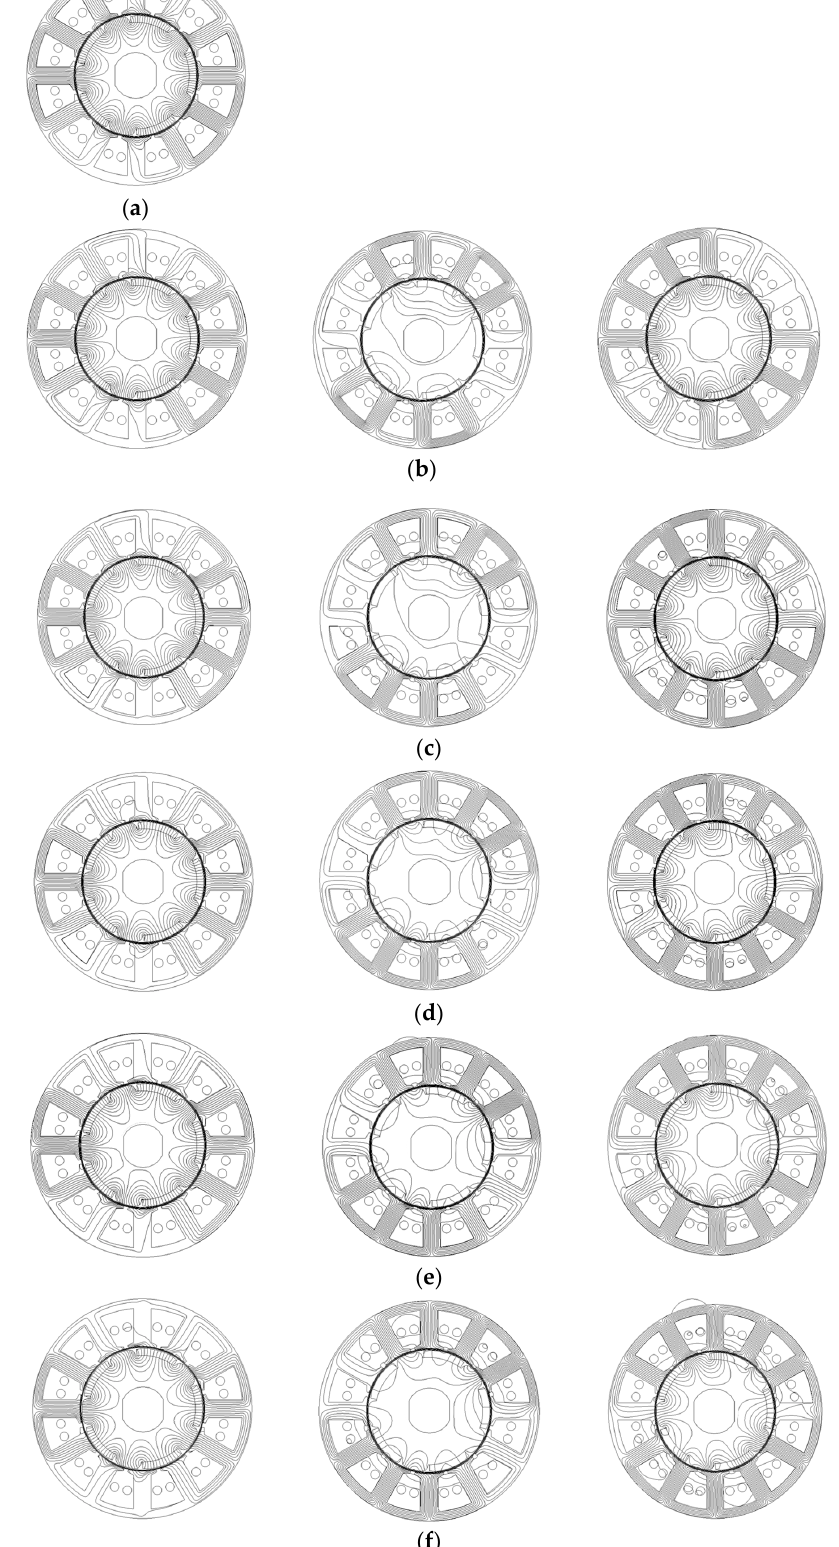
Figure 28. Equal potential distributions for 12s10p-PSCPPM. (from left to right: PM only, armature current only, overall) ( a ) 0A. ( b ) 10A ( c ) 20A. ( d ) 30A. ( e ) 40A. ( f ) 50A.